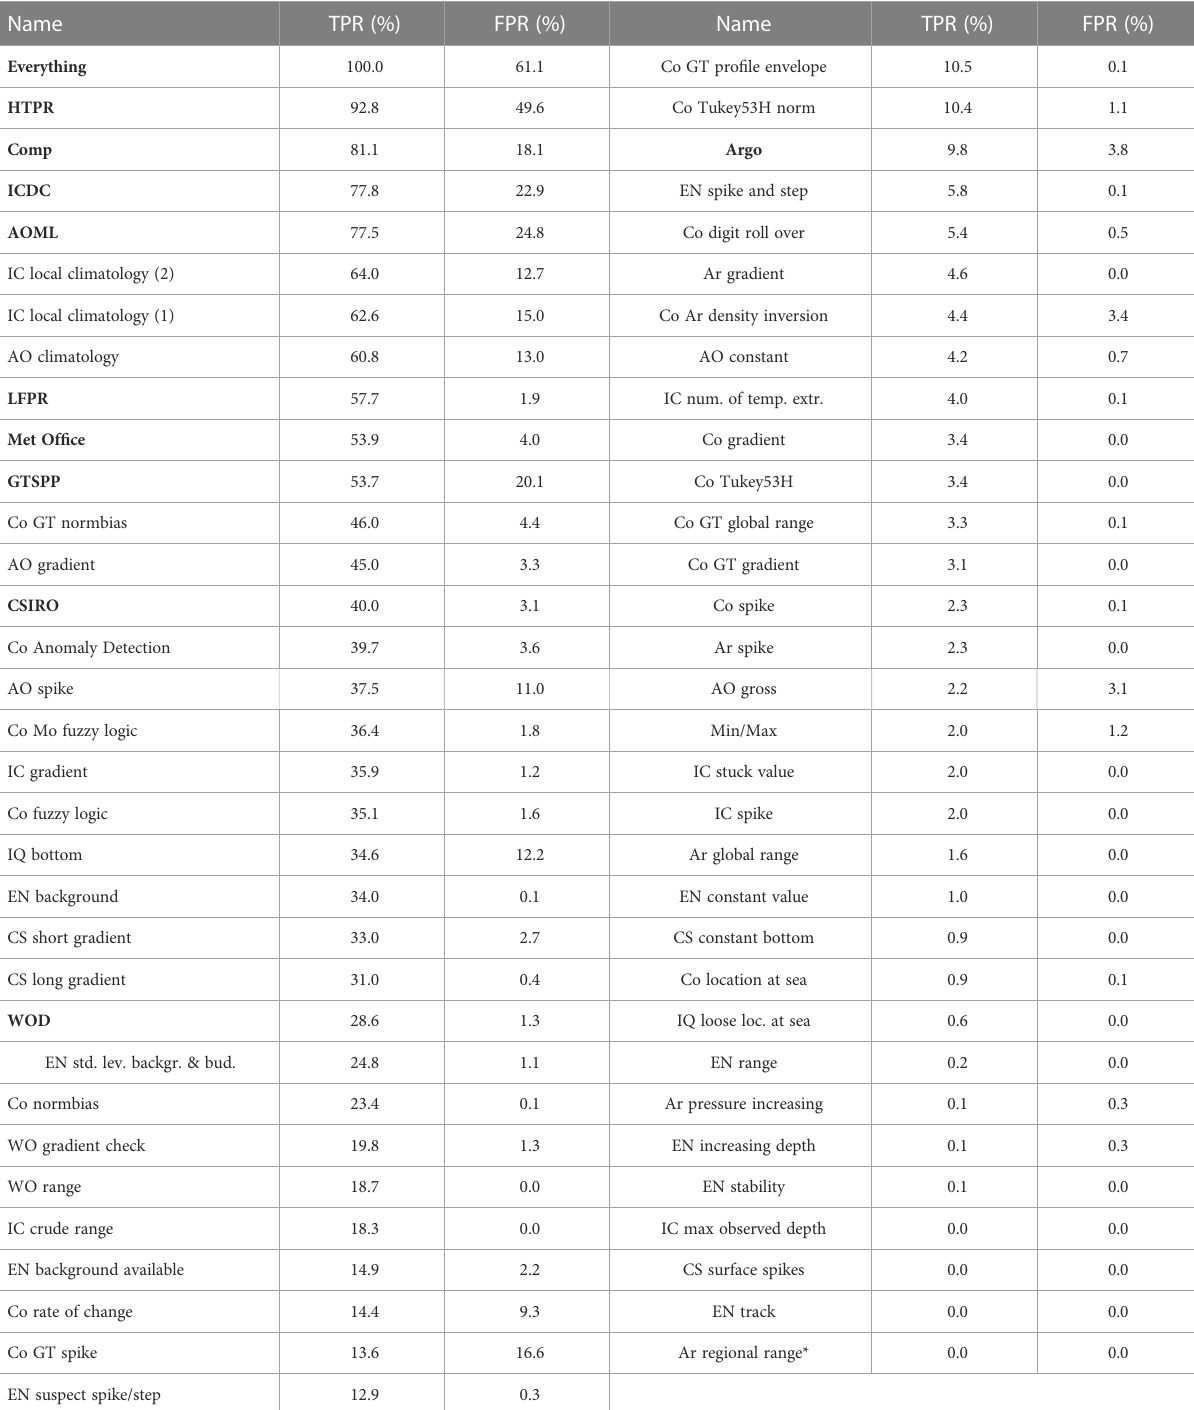
TABLE 3 TPR and FPR for individual QC checks (plain text) and combinations of checks (bold text) after removal of levels/pro fi les according to the pre-selected tests listed in Table 2